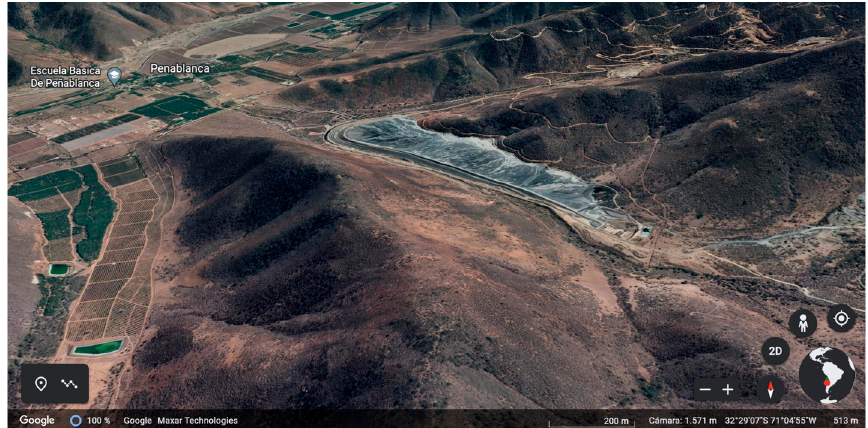
Figure 1. Tailings impoundment, property of Minera Las Cenizas. Google